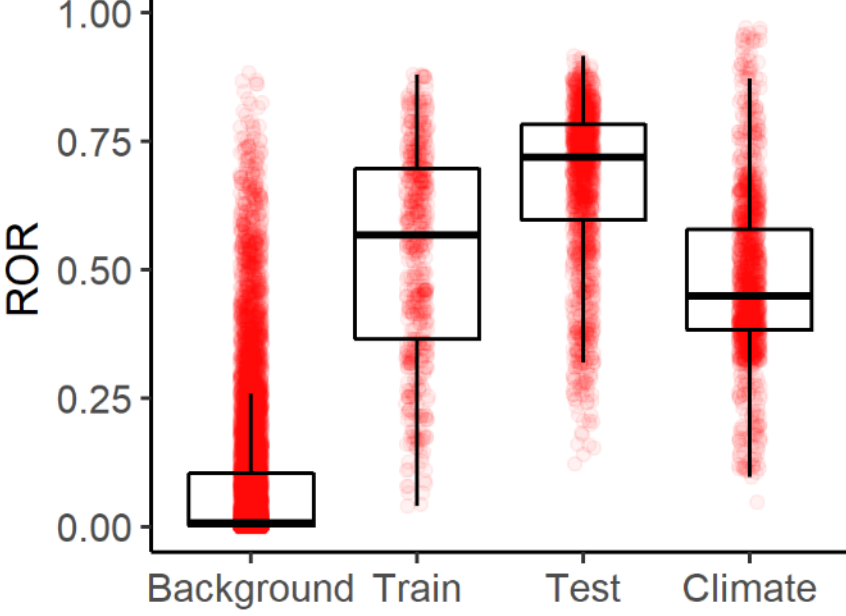
Figure 2. Boxplots of the relative occurrence rates (ROR), shown as red circles, from the full model at each of the 10,000 random background data points (background; mean ROR = 0.08), the VS locations used to train the model under current climate (train; mean ROR = 0.53), and VS locations withheld from the training analysis (test; mean ROR = 0.66). The ROR of training data were significantly higher than background locations ( p < 0.001). The ROR of test locations was also significantly higher than background locations ( p < 0.001). The ROR of training data were significantly higher than the ROR of test data ( p < 0.001). The ROR of test occurrences using the climate-only (Climate) model (mean ROR = 0.48) was significantly more than the background points ( p < 0.001) and less than the training and test points (both p < 0.001).